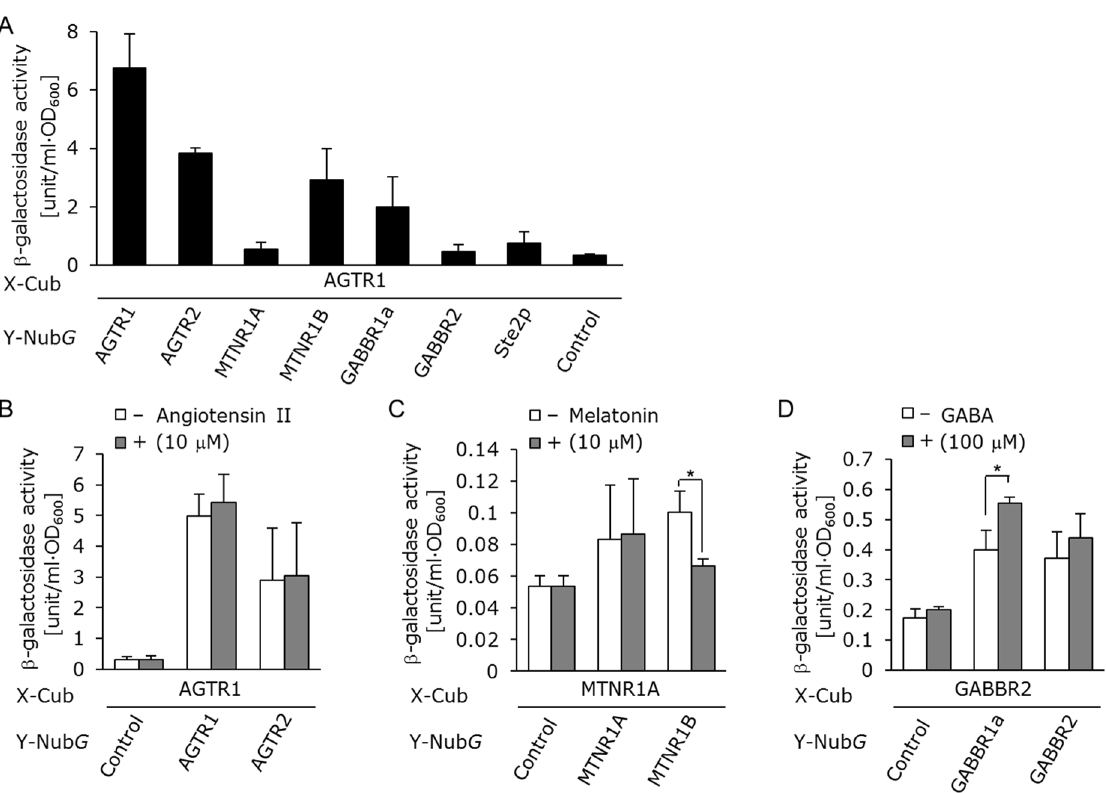
Figure 8. Detection for dimerization and ligand-induced conformational changes of human GPCRs. (A) Quantitative b -galactosidase assays for heterodimerization of AGTR1 in NMY63 strain. NMY63 yeast strain was transformed with GPCR-Nub G indicated at the bottom and AGTR1- Cub-LexA-VP16. (B–D) Ligand assays for detection of conformational changes in GPCR dimerizations. (B) AT 1 /AT 2 (AGTR1/AGTR2) heterodimers. Incubation time, 18 h. Angiotensin II conc., 0 or 10 m M. (C) MT 1 /MT 2 (MTNR1A/MTNR1B) heterodimers. Incubation time, 18 h. Melatonin conc., 0 or 10 m M. (D) GABA B1a /GABA B2 (GABBR1a/GABBR2) heterodimers. Incubation time, 18 h. GABA conc., 0 or 100 m M. The control prey plasmid was pPR3-C mock vector. Error bars represent the standard deviations ( n= 3). (* P , 0.05).